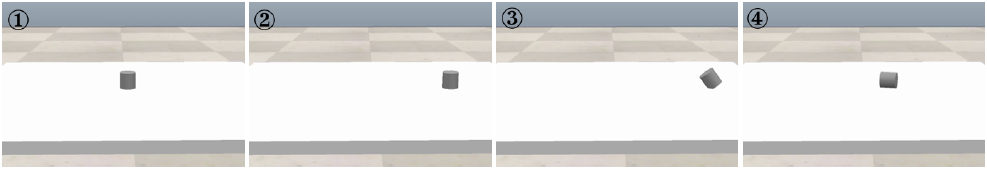
Figure 7. Snapshot of failure case of multipoint contact scenario: the contact force is not properly simulated, so the cylinder cannot stand upright and falls over time ( 1 → 4